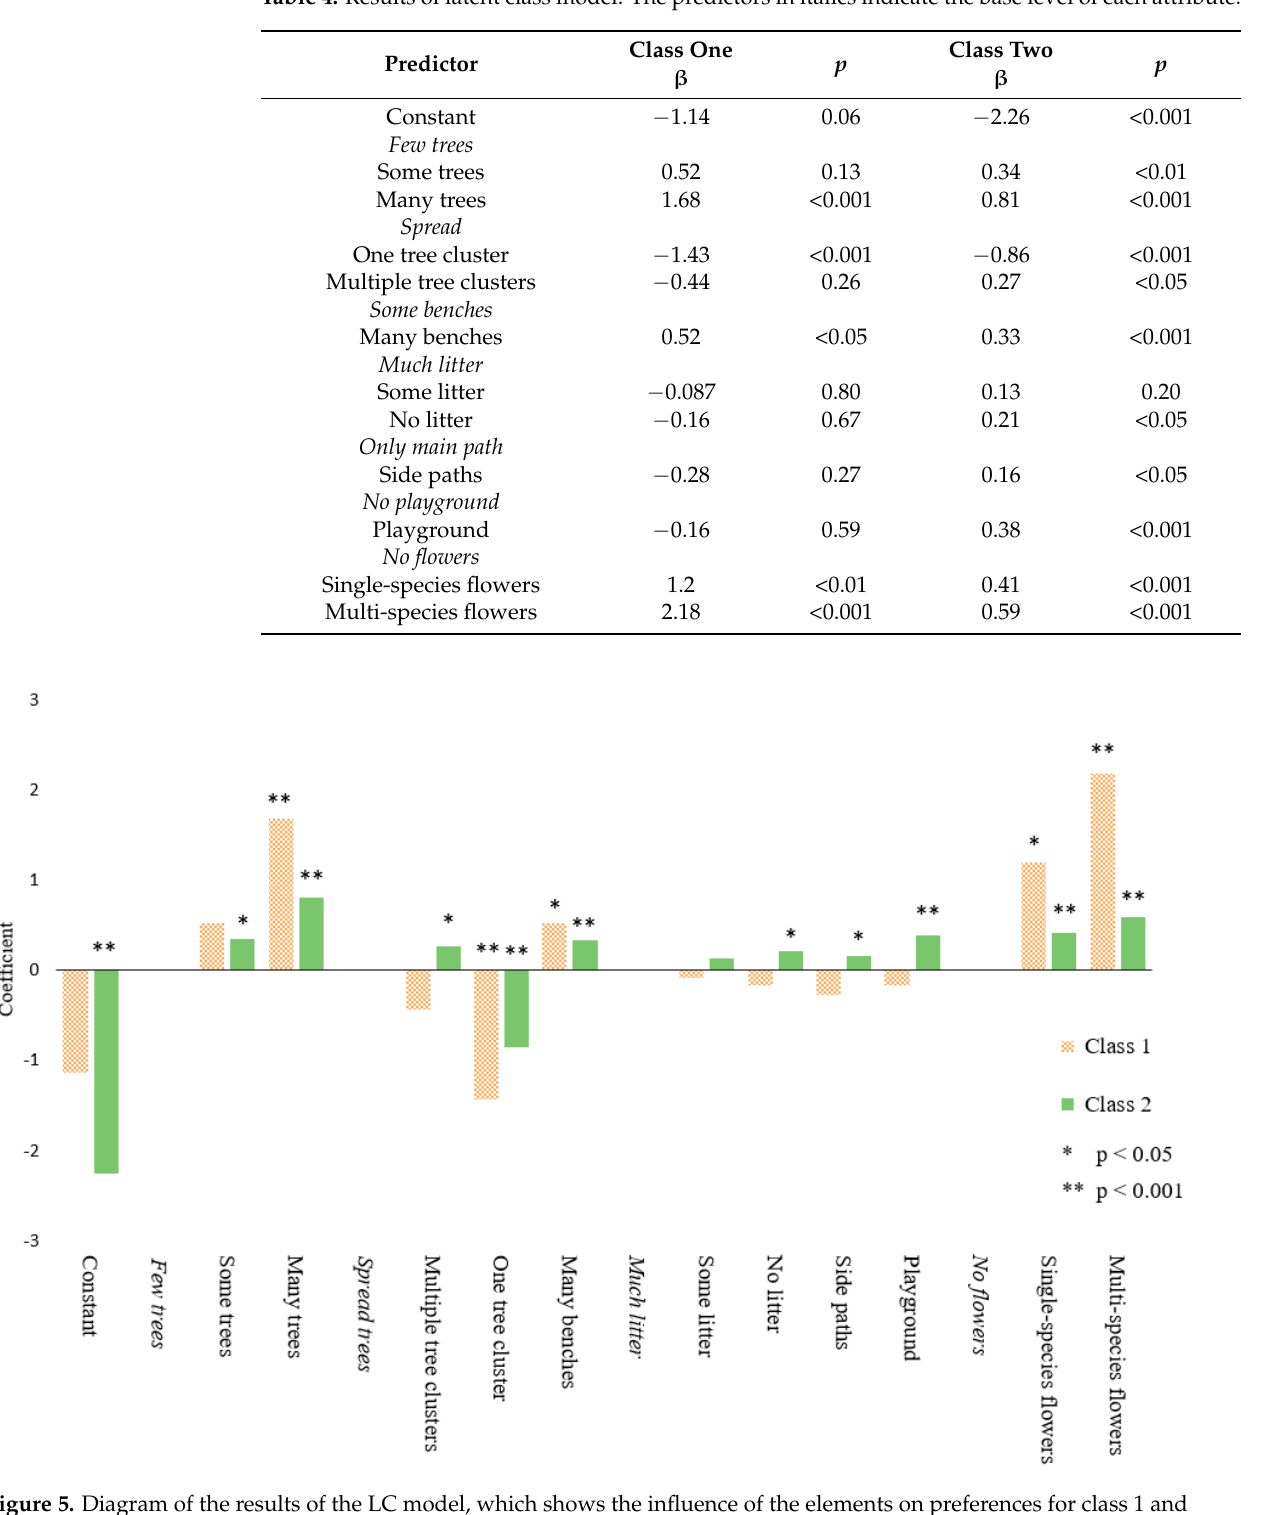
Table 4. Results of latent class model. The predictors in italics indicate the base level of each attribute.